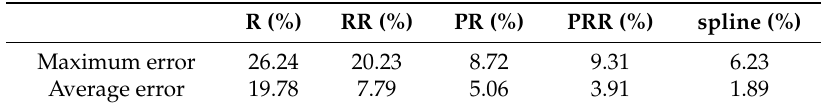
Table 2. Relative error of